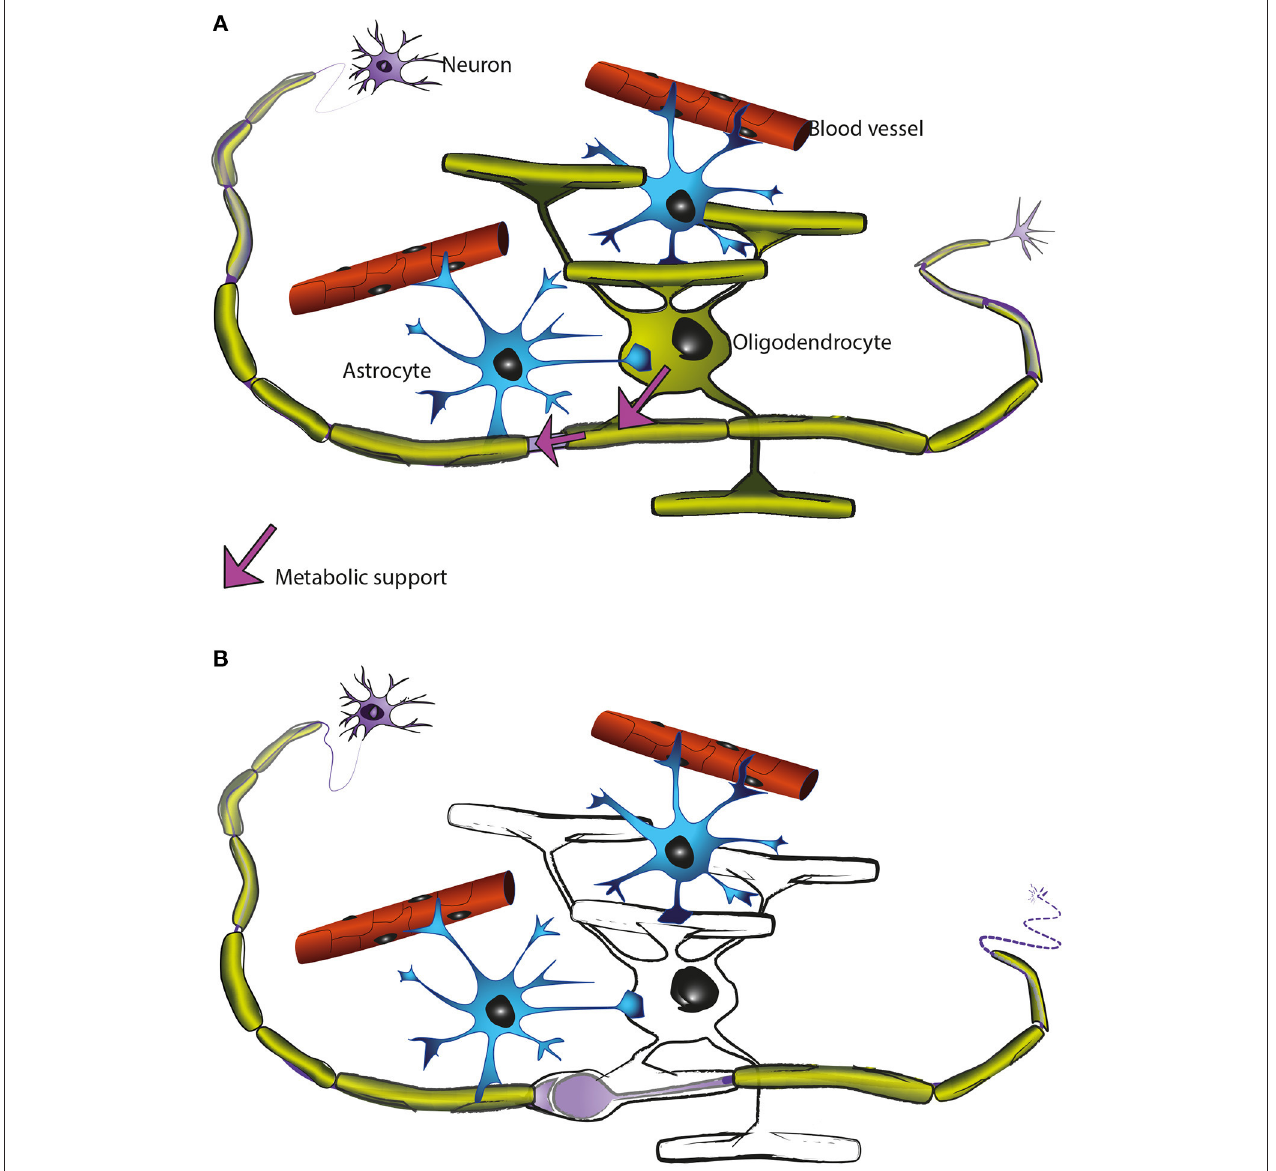
FIGURE 5 | Oligodendrocytes support axons. (A) In the CNS, oligodendrocytes (green) provide axons with the insulating myelin sheath (green: myelinated internodes). Moreover, oligodendrocytes support axonal integrity and function independent of myelination per se (for details see main text). Astrocytes (blue) not only contact blood vessels but additionally interact with axons and oligodendrocytes and contribute to brain homeostasis. Oligodendrocyte precursor cells (not illustrated) are also present in the mature CNS and are the main cellular source for new oligodendrocytes after injury and in remyelination. (B) Oligodendrocyte dysfunction leads to a perturbed axon-glia interaction which ultimately impairs axonal health. As the myelinic channel system is likely acting as a route by which oligodendrocytes supply metabolites to the myelinated axons, any perturbation of this system could potentially impact axonal integrity, resulting for example in focal axonal swelling and distal axonal